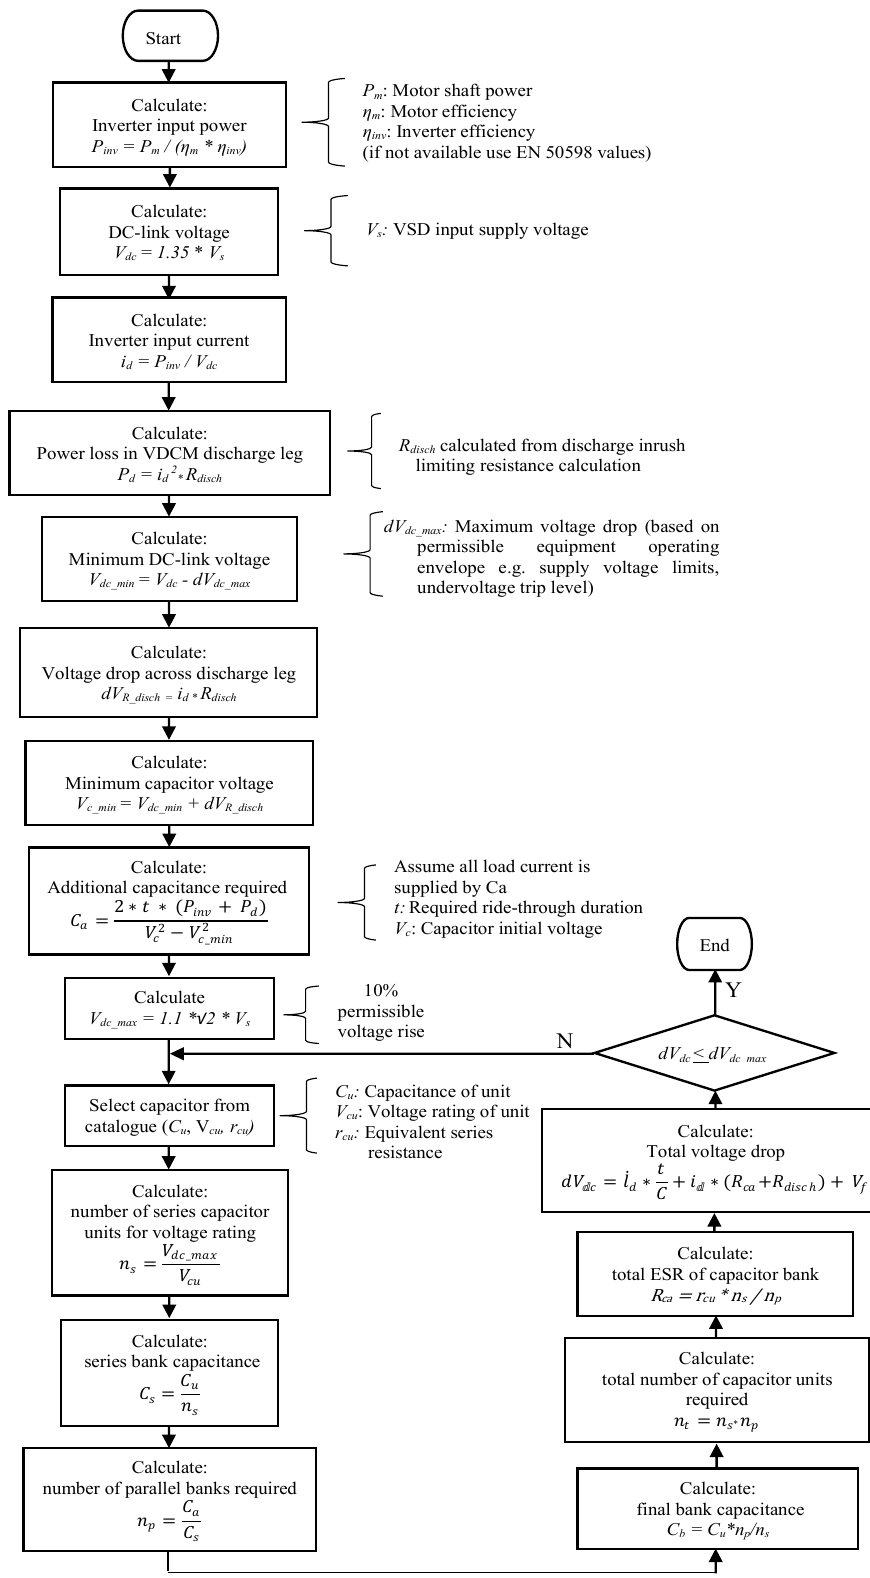
Figure 5. Switched capacitor sizing flowchart.